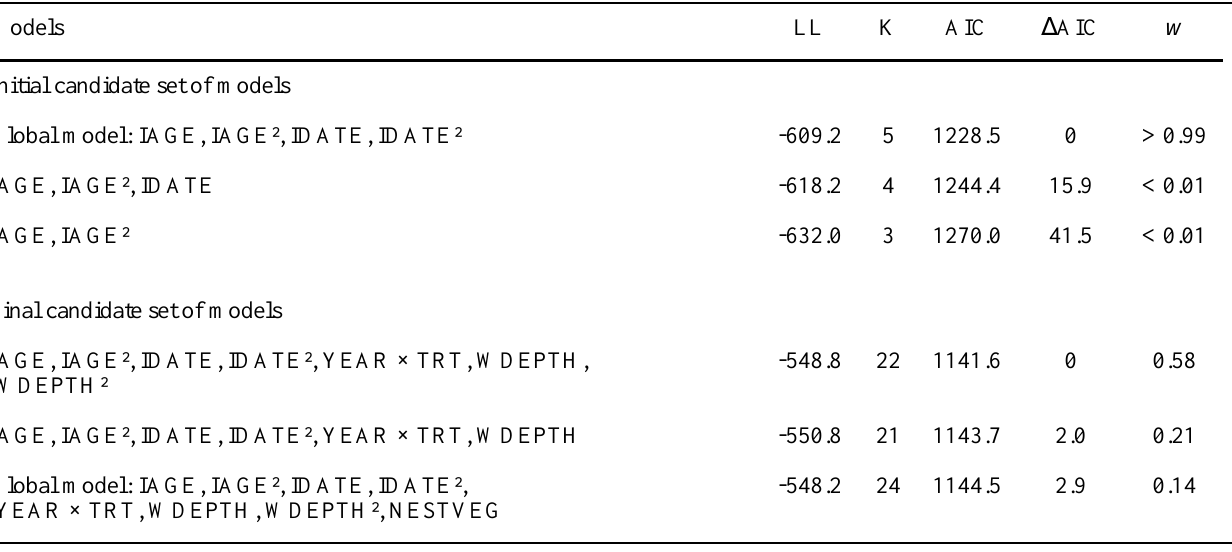
Table 3. Log likelihood (LL), number of parameters (K), AIC, D AIC, and Akaike weight (w) for the top three models of the initial and final analyses of American Coot ( Fulica Americana ) nest survival at Grays Lake, Idaho, 1997–2000. The initial candidate set of models included age (IAGE) and date (IDATE) and their quadratic functions; the final candidate set of models included age, date, water depth (WDEPTH), nest vegetation (NESTVEG), and year x treatment (YEAR × TRT) variables, including the quadratic terms for age, date, and water depth. Effective sample size was